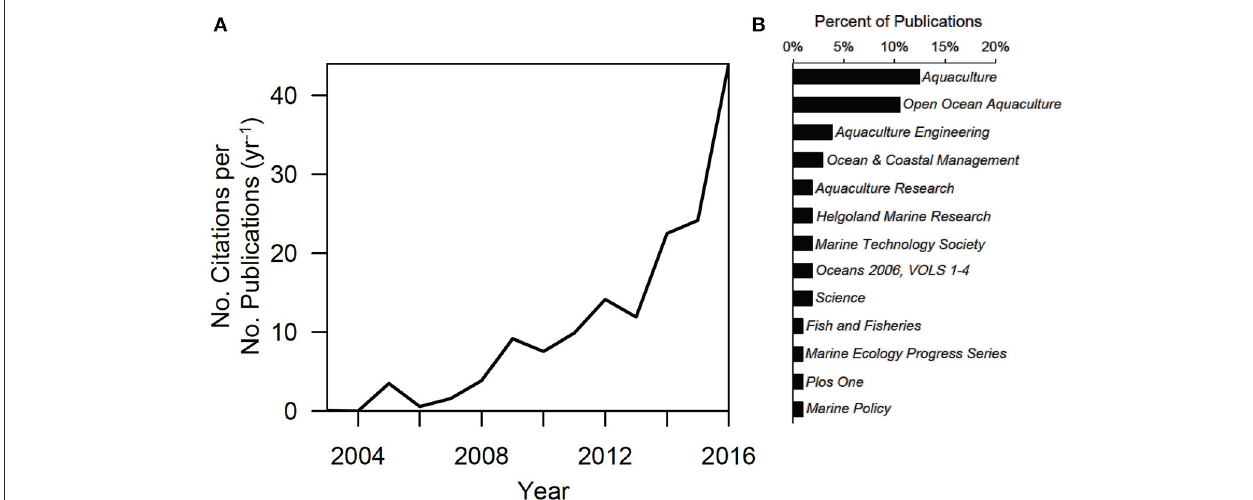
FIGURE 1 | (A) Web of Science (WOS) citations of “offshore aquaculture” over time, relative to the number of publications per year and (B) the associated journals pertaining to the publications (percent contribution).